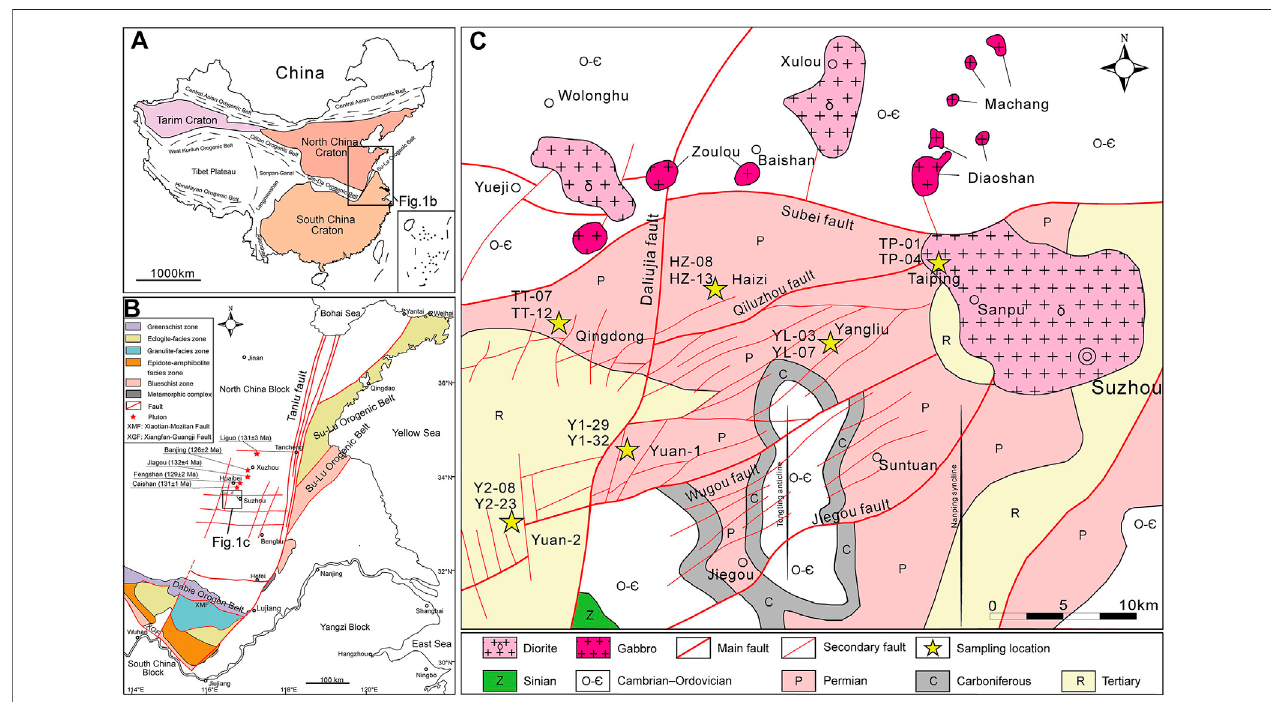
FIGURE 1 | Tectonic maps of China (A) and North China (B) , and (C) geologic map of the Huaibei-Linhuan coal fi eld, showing the distribution of basement rocks, sampling sites and major structures (modi fi ed after Zhao et al., 2016; Zhu et al., 2005, 2009; An et al., 2018).